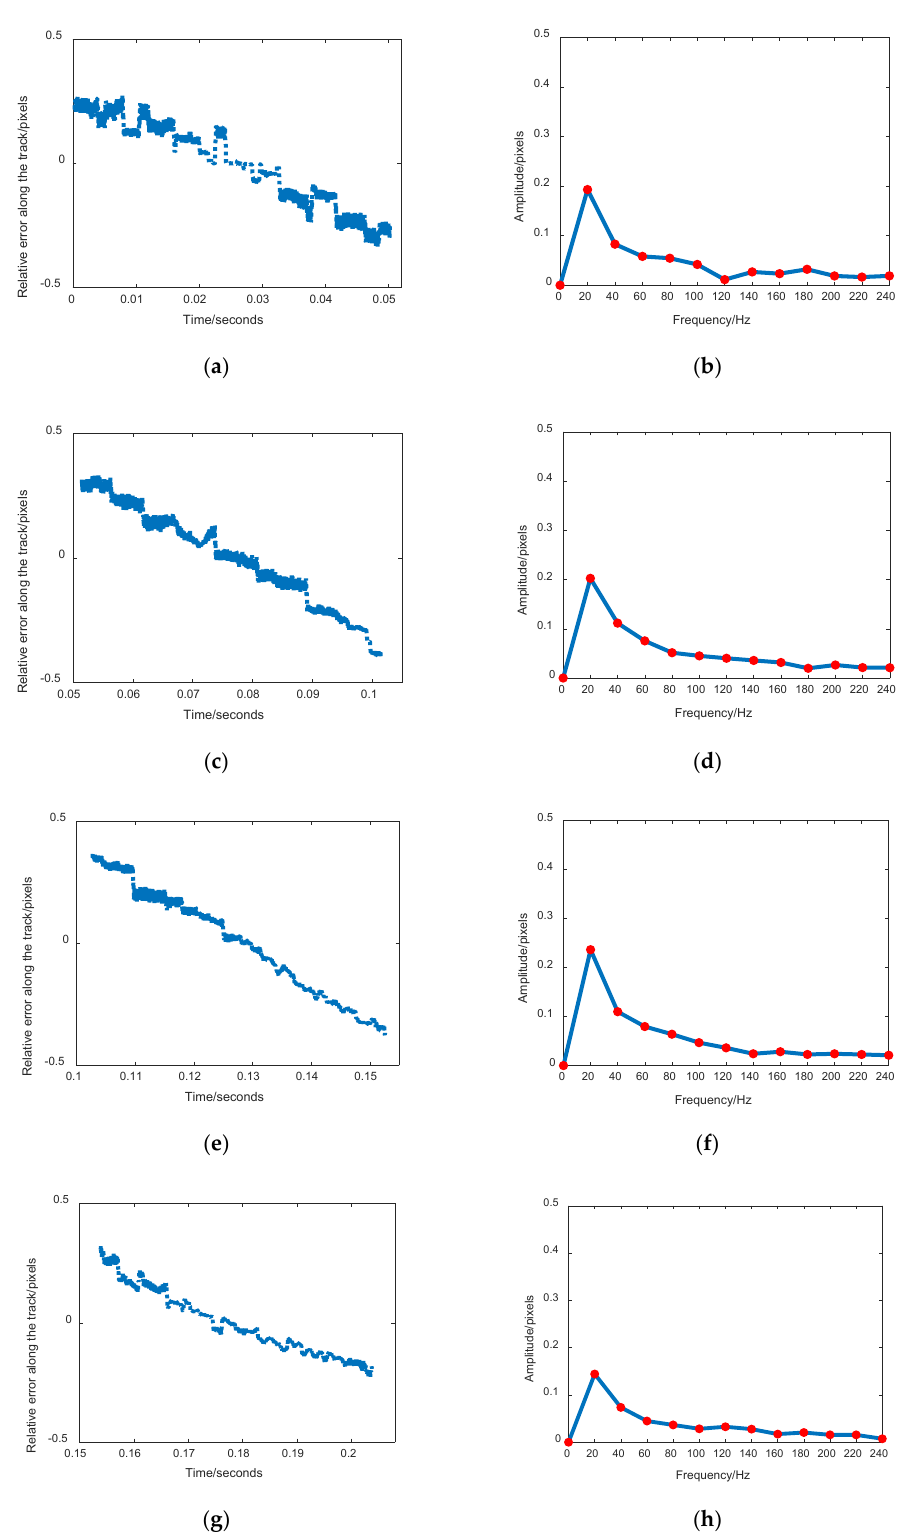
Figure 7. The 2-Hz Jitter detection curves and Fourier analysis results by single disparity map generated from two adjacent sequence images. ( a ): Jitter detection curve by image 1–2; ( b ): Fourier analysis results of jitter detection curve by image 1–2; ( c ): Jitter detection curve by image 2–3; ( d ): Fourier analysis results of jitter detection curve by image 2–3; ( e ): Jitter detection curve by image 3–4; ( f ): Fourier analysis results of jitter detection curve by image 3–4; ( g ): Jitter detection curve by image 4–5; ( h ): Fourier analysis results of jitter detection curve by image 4–5.